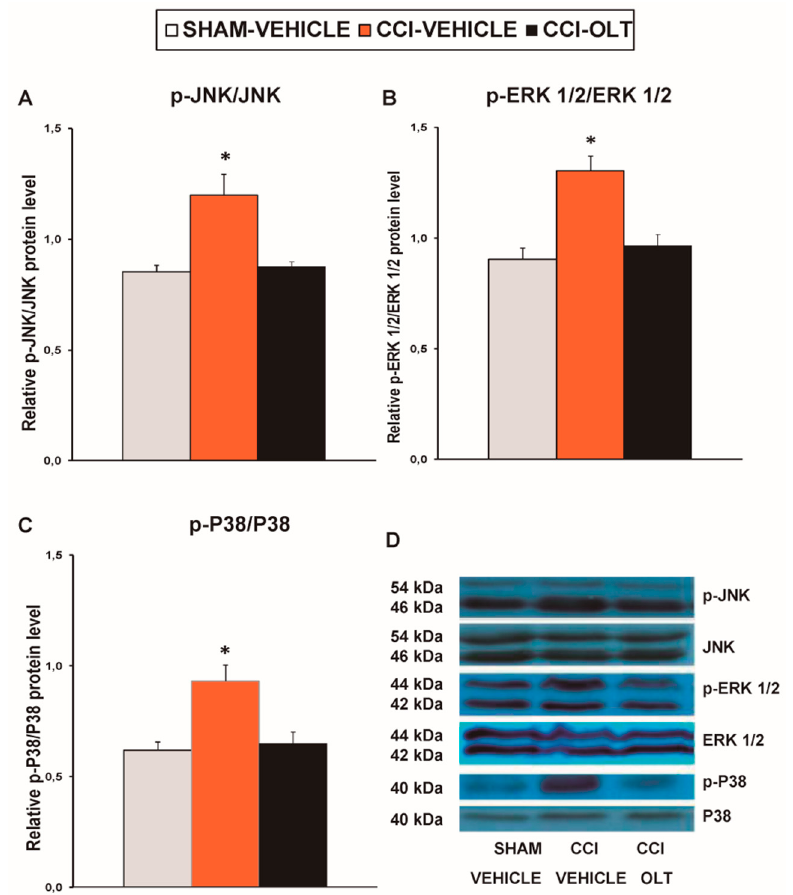
Figure 5. Effects of oltipraz on the expression of phosphorylated c-Jun N-terminal kinase (p-JNK), phosphorylated extracellular signal regulated kinase 1/2 (p-ERK 1/2), and p-P38 in the spinal cord of the CCI-injured mice. The relative protein levels of ( A ) p-JNK, ( B ) p-ERK 1/2, and ( C ) p-P38 on the ipsilateral side of the spinal cord of the CCI-injured mice treated with oltipraz (OLT) or vehicle are represented. The sham-operated mice (SHAM) treated with vehicle were used as controls. Phosphorylated proteins are expressed relative to their corresponding total protein levels. ( D ) Representative examples of blots for p-JNK/total JNK protein (46–54 kDa), p-ERK ½/total ERK ½ (42–44 kDa), and p-P38/total P38 (40 kDa). In all panels, * denotes significant differences vs. sham-operated mice treated with vehicle ( p < 0.05; one-way ANOVA followed by the SNK test). Results are presented as the mean ± SEM; n = 5 samples per experimental group.